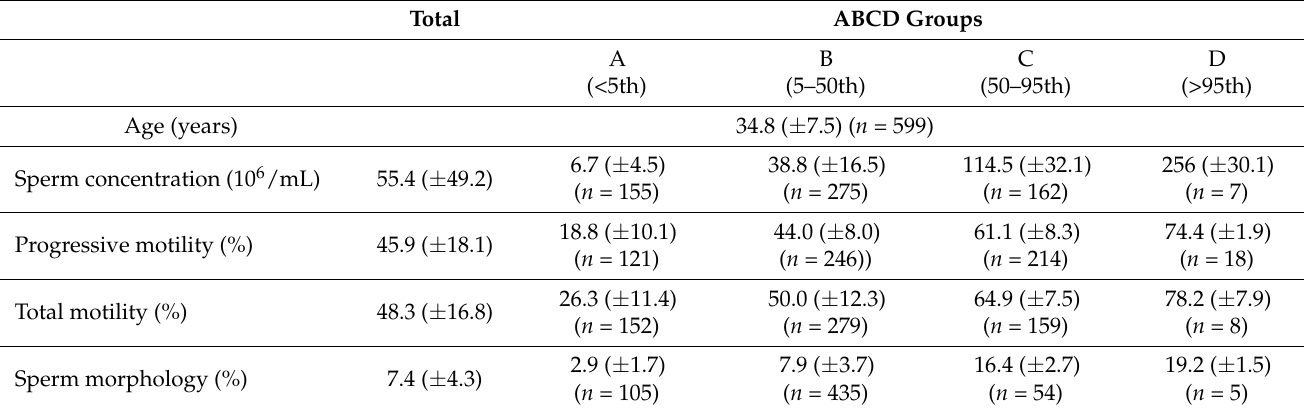
Table 1. Age and seminal characteristics of enrolled patients.